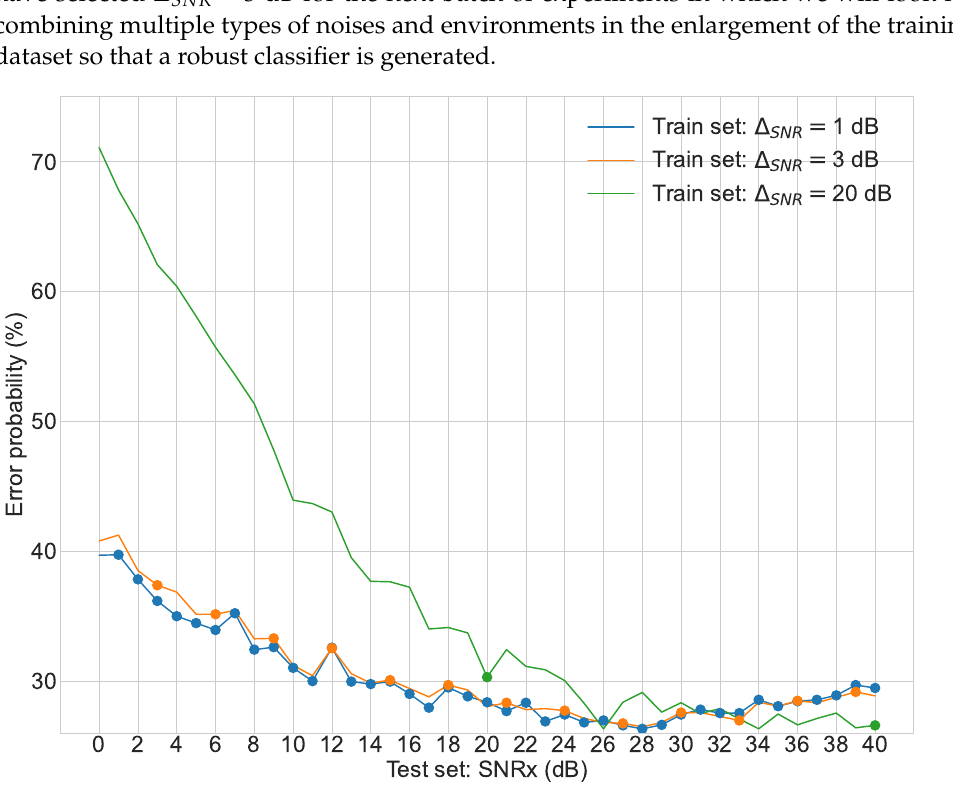
Figure 3. Second stage experiment results: test sets error probabilities for three different models (White Gaussian Noise